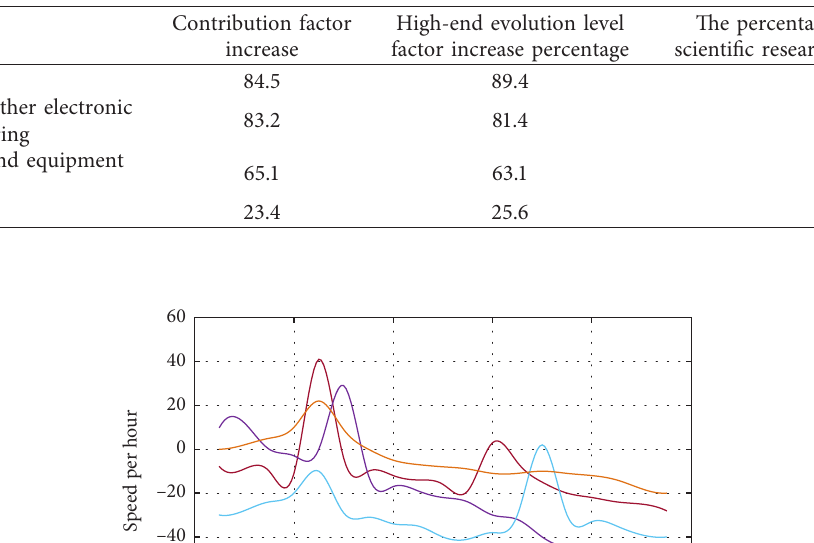
Table 3: Results of some code of some industries.